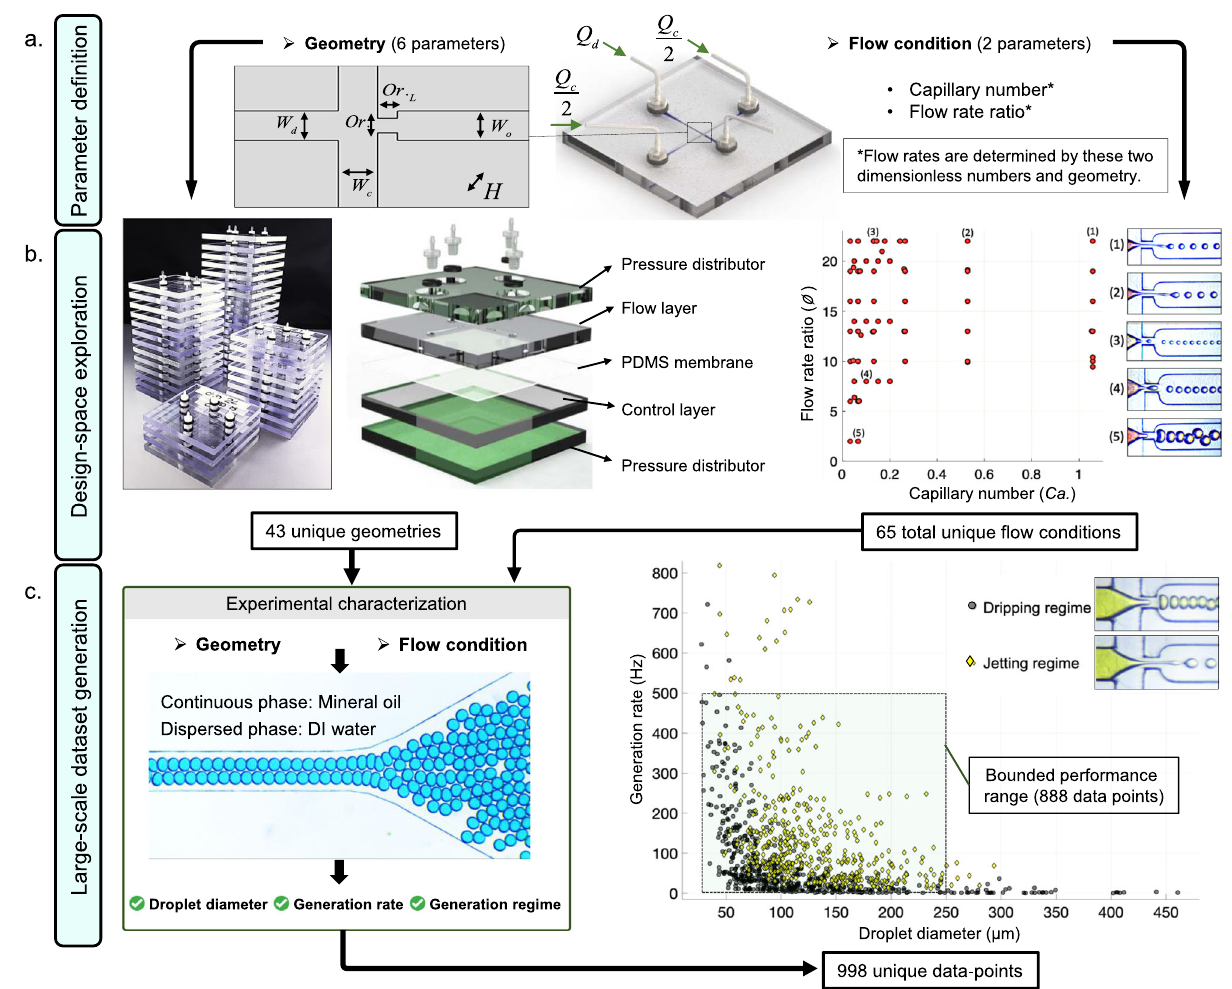
Fig. 2 Rapid prototyping enables ef fi cient generation of data-sets suitable for training machine learning algorithms. a The six parameters de fi ning a fl ow-focusing geometry were varied according to an orthogonal design of experiments. Capillary number and fl ow rate ratio were used to determine the fl ow rates for each device. b A total of 43 devices were fabricated using a low-cost micromill and assembly technique. Each device is tested over a wide range of fl ow conditions to generate a large-scale data-set. c For each experiment, droplet diameter, generation rate, and generation regime were recorded. A total of 998 data-points were collected of the observed performance and their associated design parameters. The machine learning algorithms were trained on a bounded performance range of 25 – 250 μ m for droplet diameter and 5 – 500 Hz for generation rate. The bounded range included 888 data- points with a comparable representation of both dripping and jetting regimes.